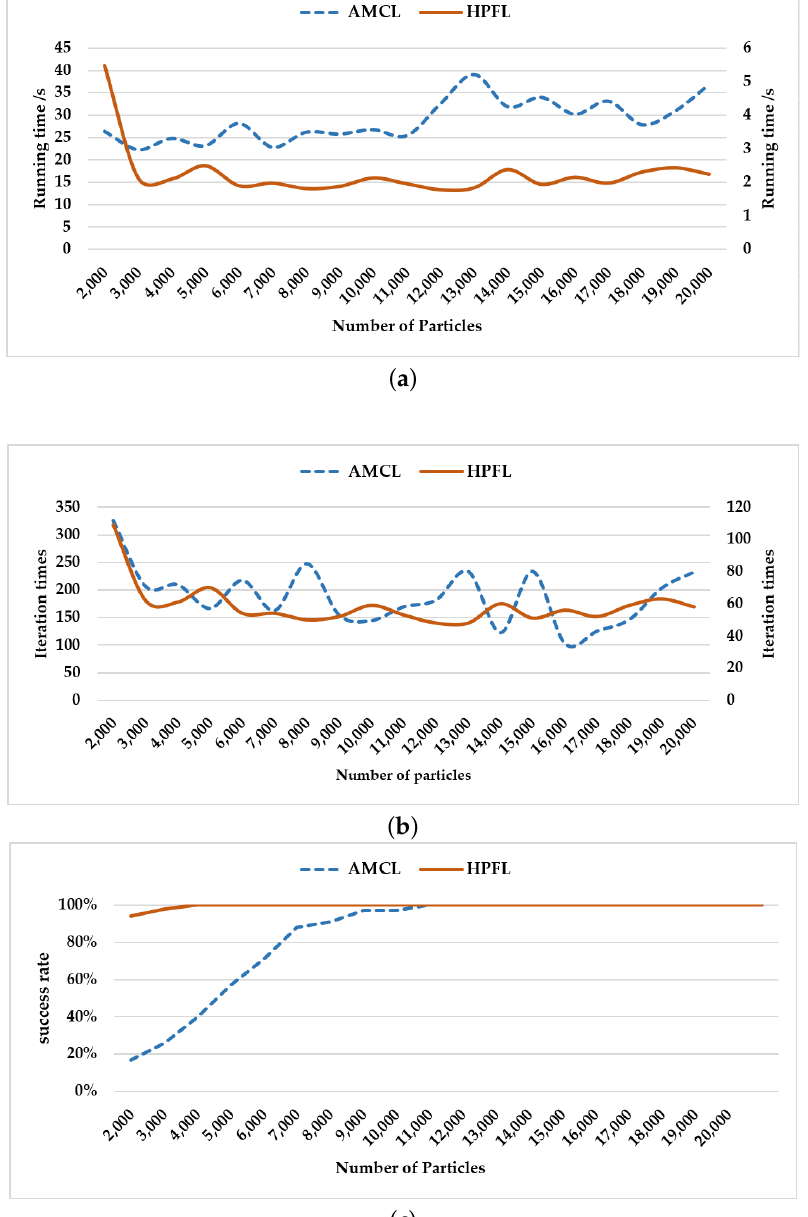
Figure 10. ( a ) Running time for AMCL and HPFL with different numbers of particles. The left y -axis is the running time for AMCL, and the right y -axis is the running time for HPFL. ( b ) Iteration times of AMCL and HPFL with different numbers of particles. The left y -axis is the number of iterations of AMCL, and the right y -axis is the number of iterations of HPFL. ( c ) Success rate of AMCL and HPFL with different numbers of